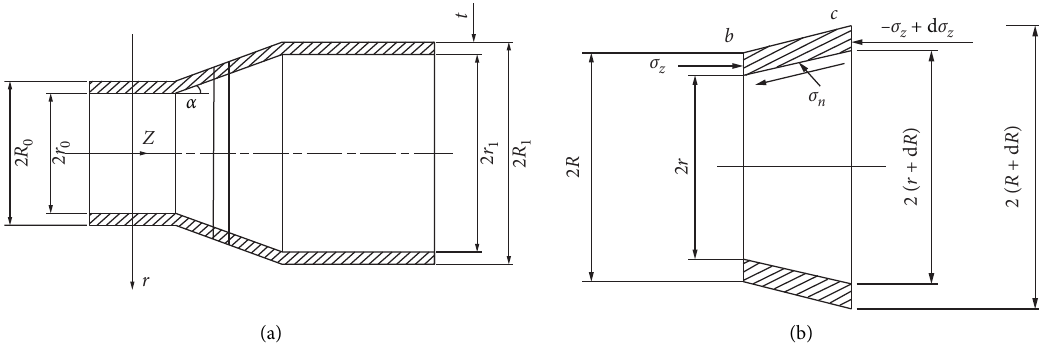
Figure 3: Diameter and base body. (a) Radius expansion diagram. (b) Primitive body force